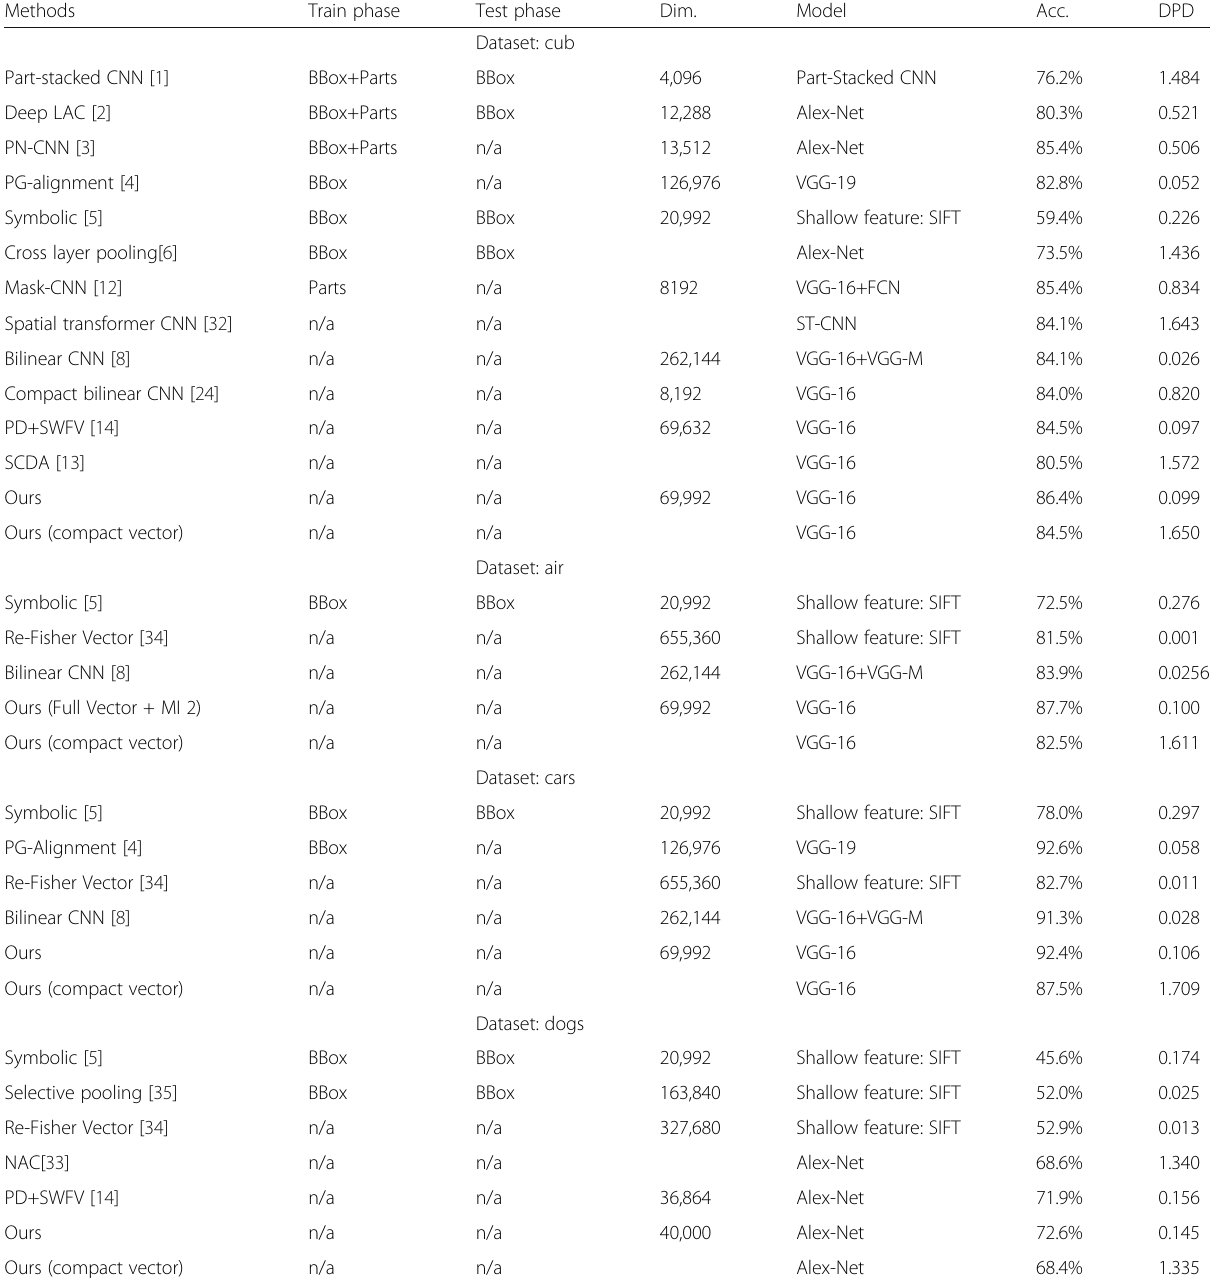
Table 5 Comparison of performance of our methods with some recent state-of-the-art methods in cub. BBox, parts denote bounding-box and parts annotation respectively